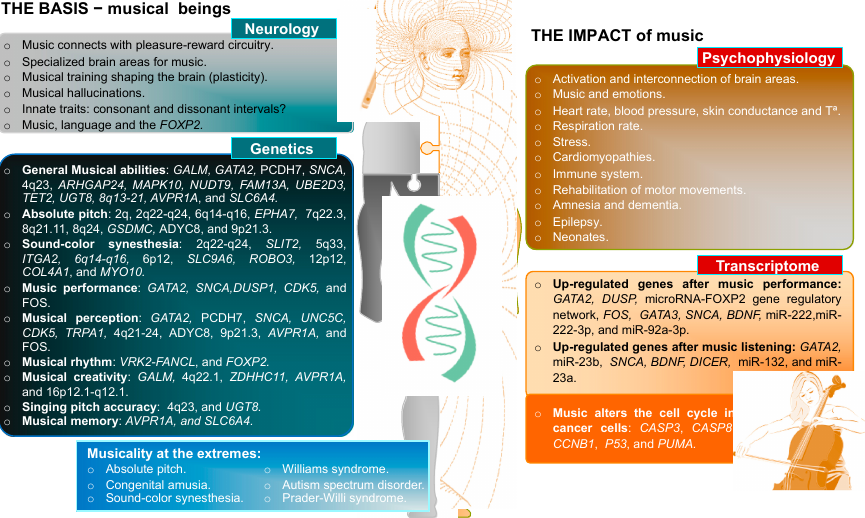
Figure 1. Scheme summarizing the known genetic and neurological basis of music and its impact on psychophysiology and transcriptome, according to the state-of-the-art of science. Supplementary Materials: The following are available online at www.mdpi.com/arti ‐ cle/10.3390/genes12091454/s1, Supplementary Data.